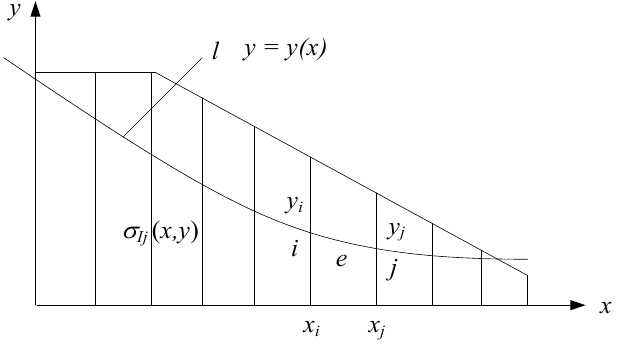
Figure 1. Discreteness of the slip surface.